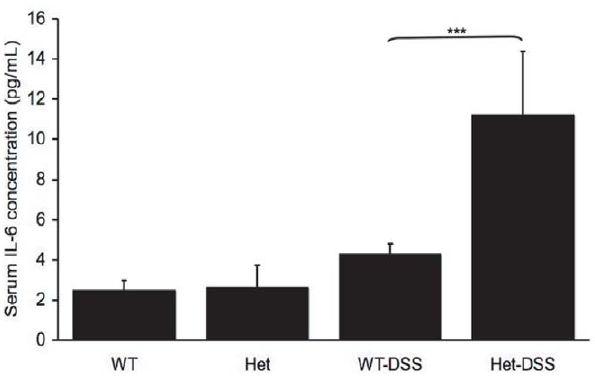
Figure 6. IL-6 serum level in DSS-treated and control mice. Serum was collected at the time of euthanasia and analyzed for cytokine levels using Mouse Cytokine Multiplex Assay. A 4.2-fold increase in serum IL-6 concentration in the TC-PTP + / 2 (Het-DSS) (11.6 6 7.6 pg/ml) compared to TC-PTP + / + (WT-DSS) (2.6 6 2.4 pg/ml) mice (p , 0.05).